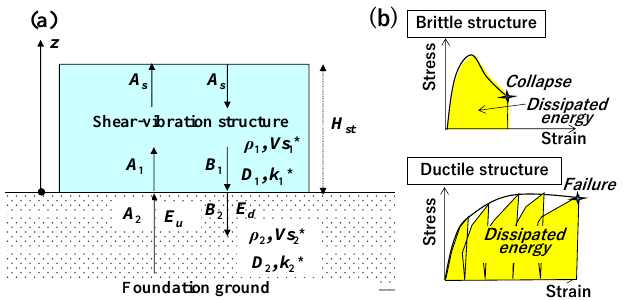
Figure 18. Shear–vibration structure resting on foundation ground approximated by a two-layer system ( a ) and its stress–strain relationships and dissipated energies for brittle and ductile structures ( b ). The horizontal displacement in each layer is expressed in Equations (14) and (15) using the amplitudes of upward and downward waves A 1 , B 1 in the superstructure, and A 2 , B 2 in the foundation ground,